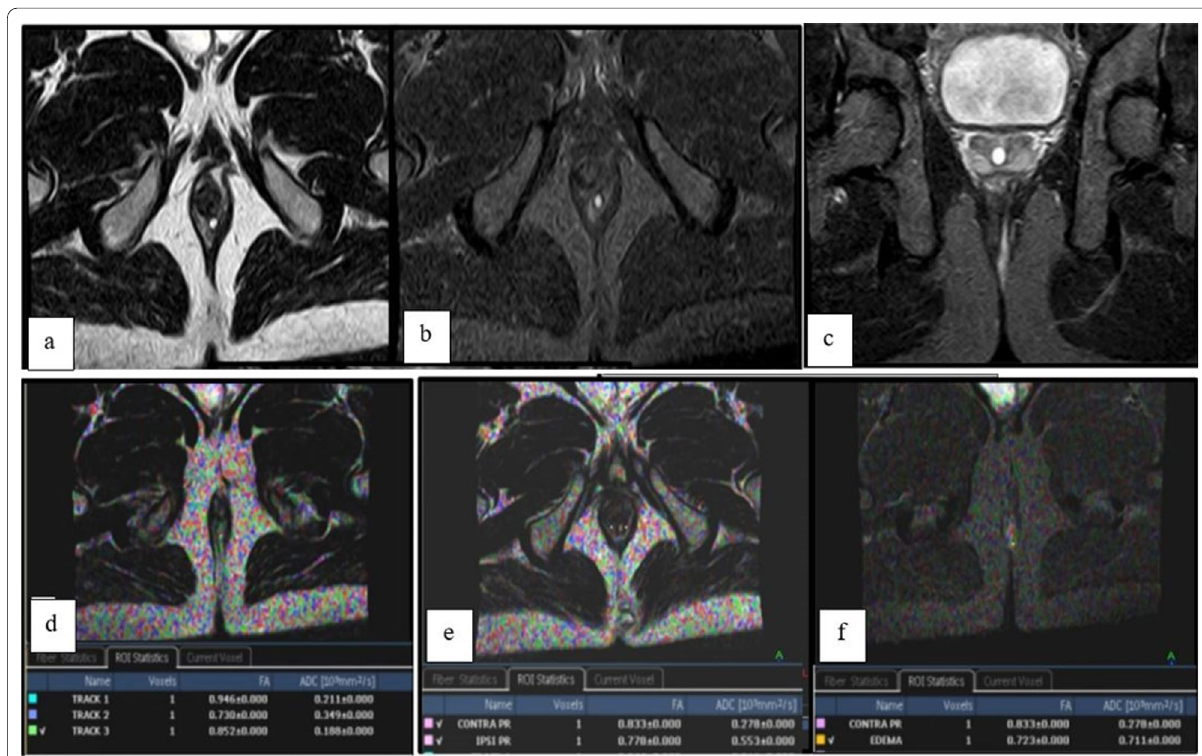
Fig. 3 a axial T2 WI, b STIR WI and c coronal STIR WI for a linear inter-sphincteric track of intermediate/high signal in T2/STIR WI touching the internal sphincter at 4–5 O’ clock. Axial DTI/T2 fused images with ROI (FA and ADC) values placed in d the inter-sphincteric track, e ipsilateral and contralateral sphincters and f surrounding edema area with FA values 0.852, 0.778, and 0.833 and 0.723 with ADC values 0.188,0.553, 0.278 and 0.711 10 3 mm 2 /s, respectively. The FA and ADC values are relatively high indicating inactive inflammatory condition ×